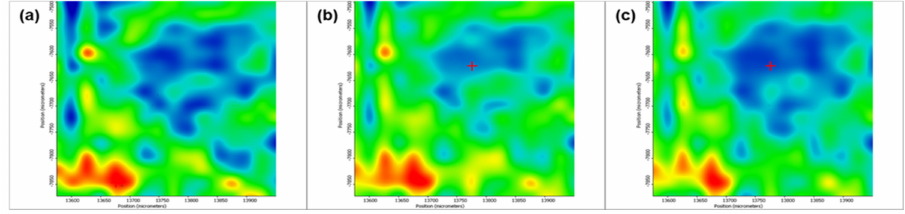
Figure 9. Second derivate IR mappings of Fe 3 O 4 @ β -CD/PTX drop-cast: surface intensity distribution of ( a ) 2930 cm − 1 , ( b ) 1029 cm − 1 and ( c ) ester/ketonic carbonyl vibration at 1739 cm − 1